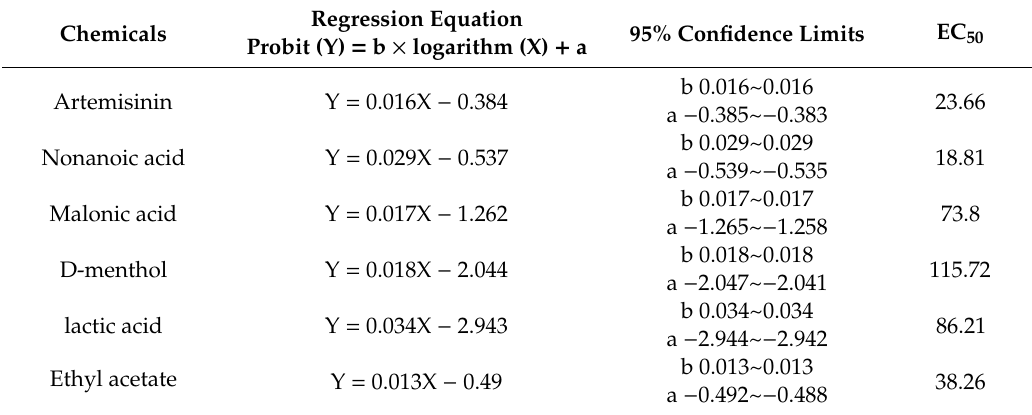
Table 3. EC 50 (mg L − 1 ) and regression equation of six chemicals against Microcystis aeruginosa.